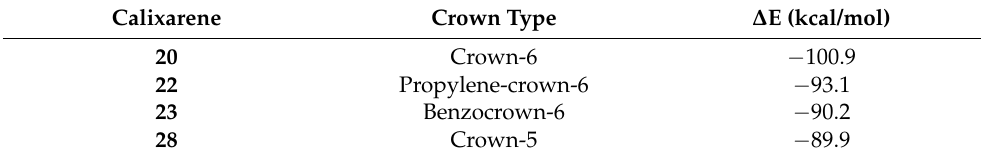
Figure 1. Calix[4]arene derivatives with modified crown ethers were used in the calculations. Table 1. Computed binding energies of different types of calixcrowns